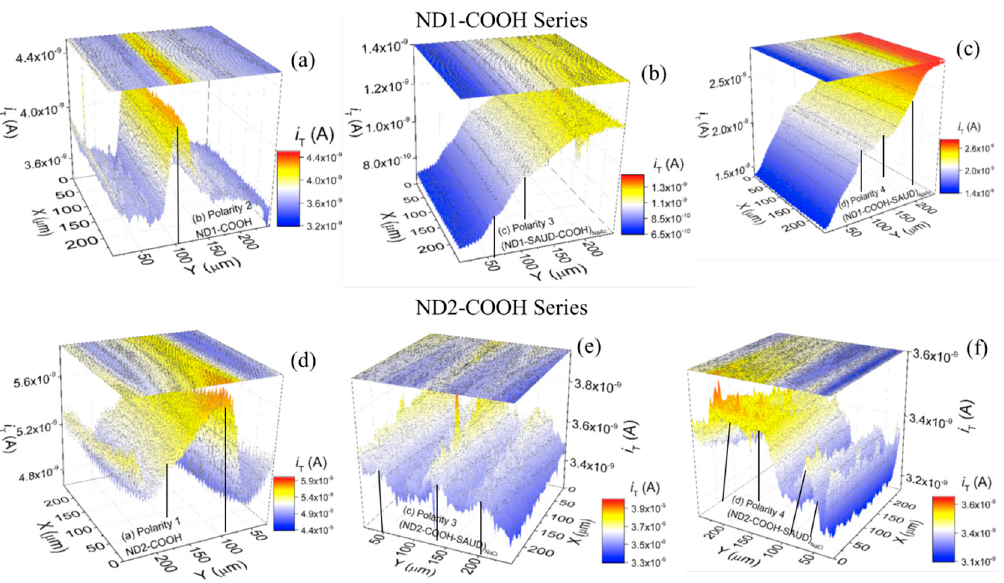
Figure 8. ( a – f ) Representative SECM images in 250 × 250 μ m 2 area of unprocessed and processed nanodiamond samples (ND1–COOH and ND2–COOH series) displaying tip current distribution in two- and three-dimensional heat maps with occasional higher (peak)/lower (valley or almost flat) current i.e., highly electroactive regions or ‘hot spots’ marked with vertical lines. A color bar is shown for quantitative values of the tip current.